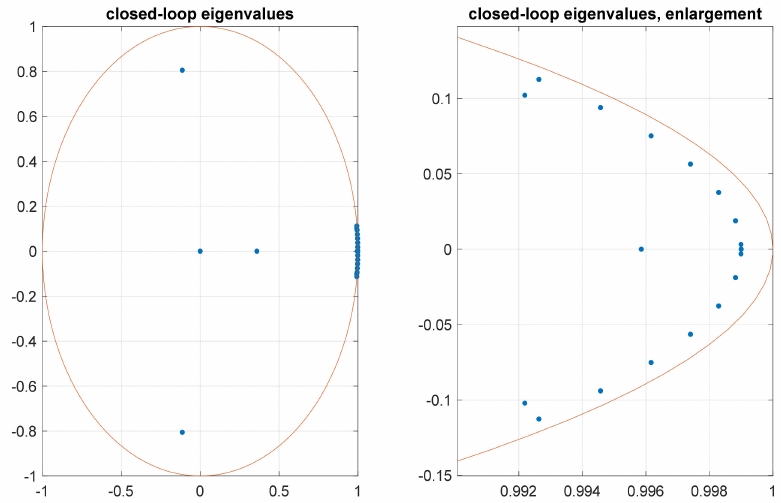
Figure 4. The eigenvalues of a closed loop RSC control system from Figure